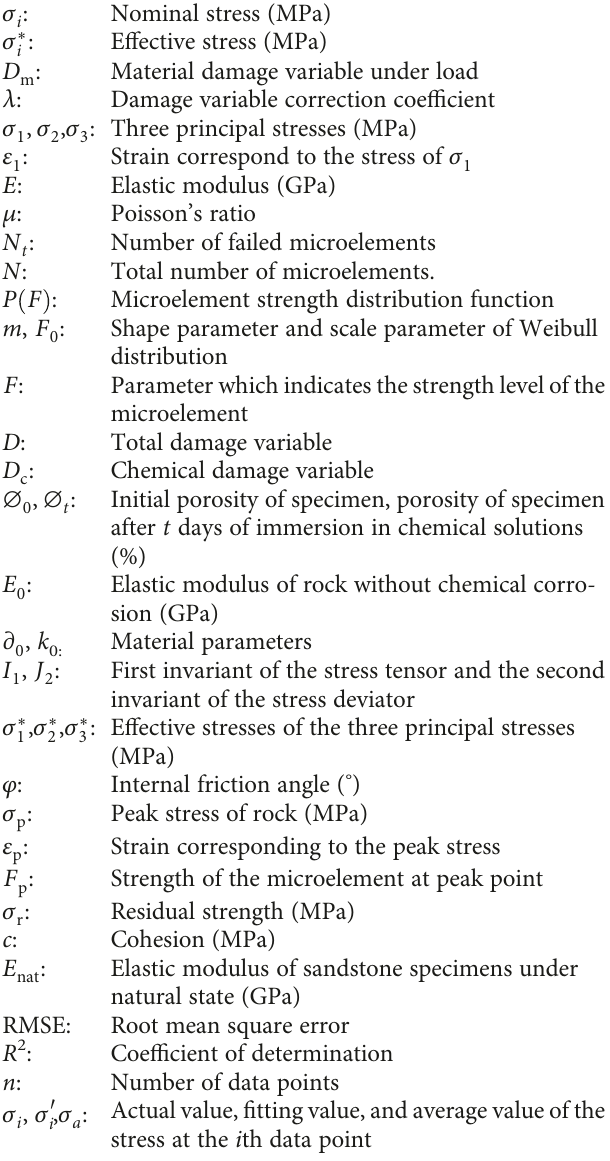
ff erent 0 with di